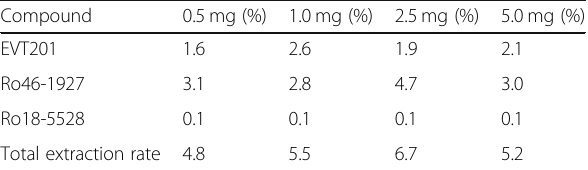
Table 4 Renal extraction rate of EVT201 and its two metabolites